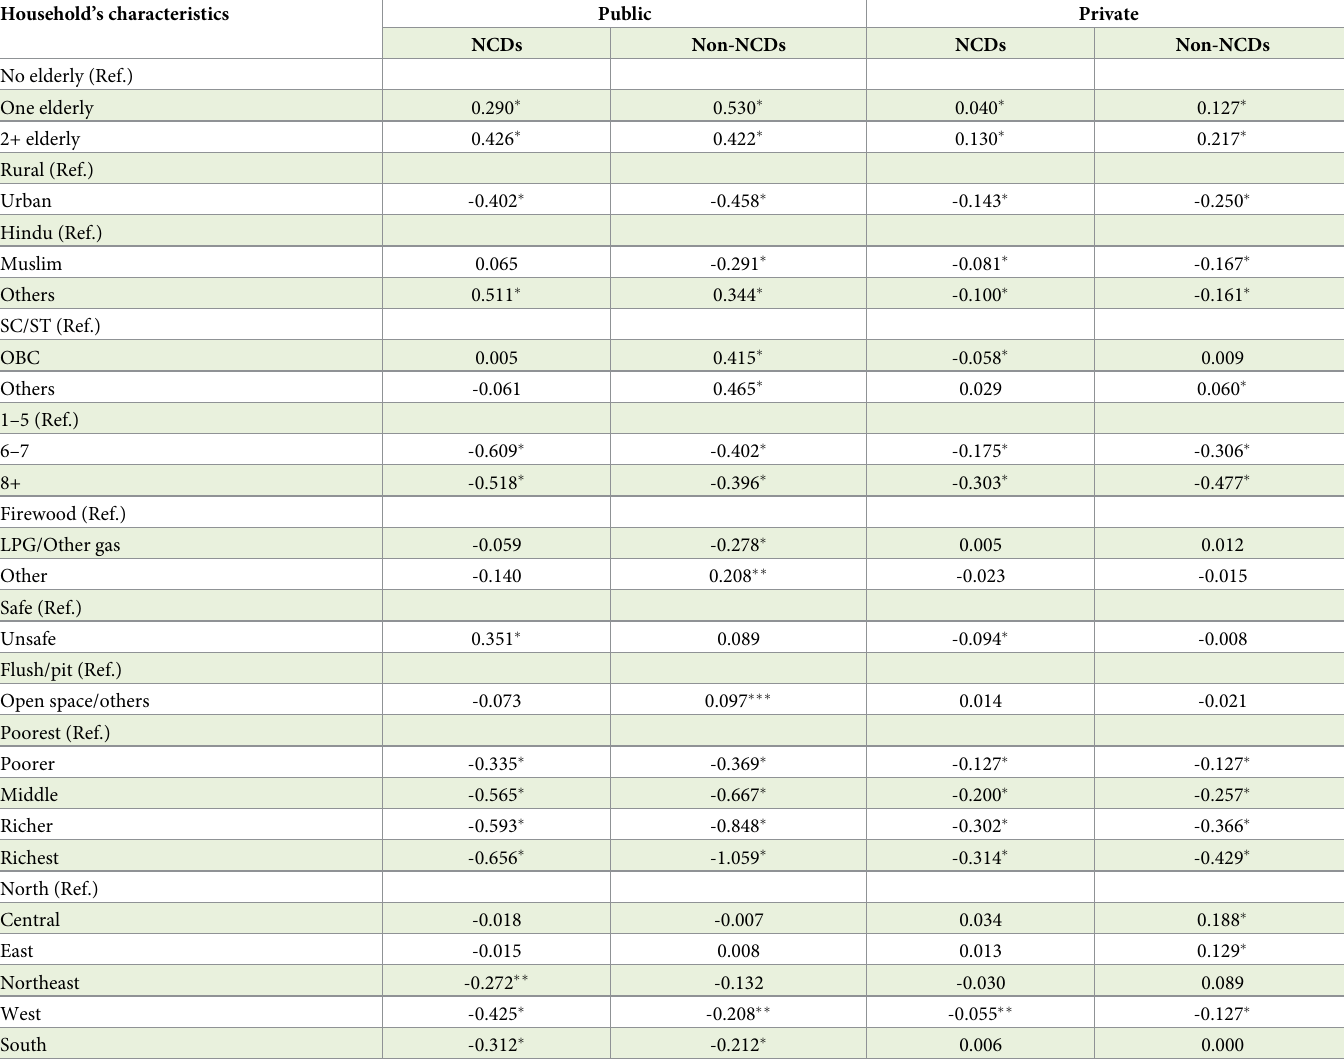
Table 5. Socio-economic factors associated with CHE due to hospitalisation by type of facility, NSSO survey 2017–18. Household’s